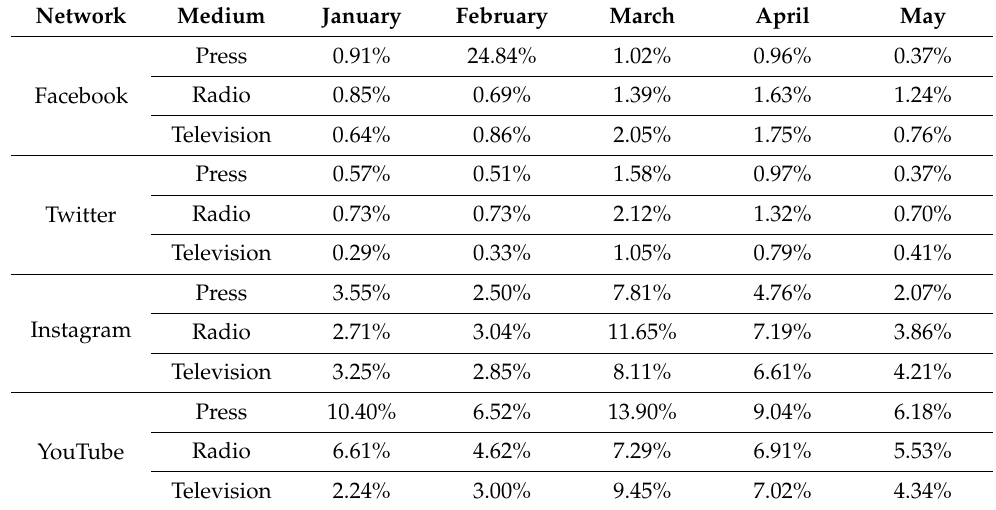
Table 5. Percentage growth of followers in the study